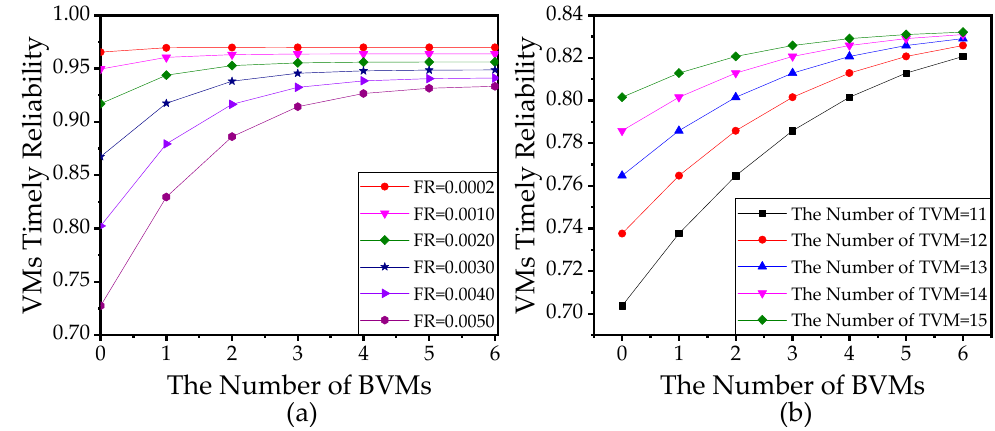
Figure 14. ( a ) VTR versus the number of backup VMs (BVM) with different failure rates (FR). ( b ) VTR versus the number of BVMs with different numbers of task VMs (TVMs) where the failure rate θ = 0.0002. In ( a , b ), the number of sensors is 10. The other parameters used in ( a , b ) refer to Table 3.